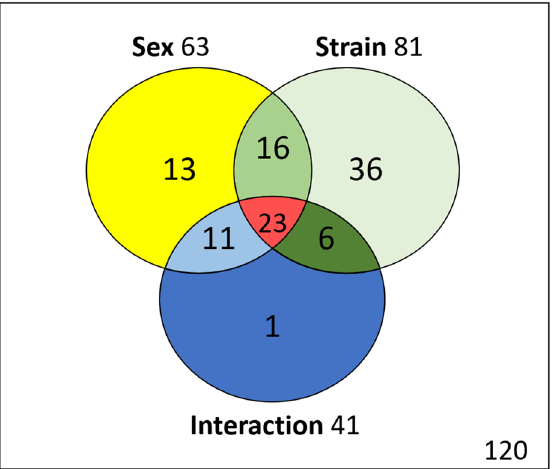
Figure 3. Venn diagram with metabolites influenced by sex or strain, and their interactions.